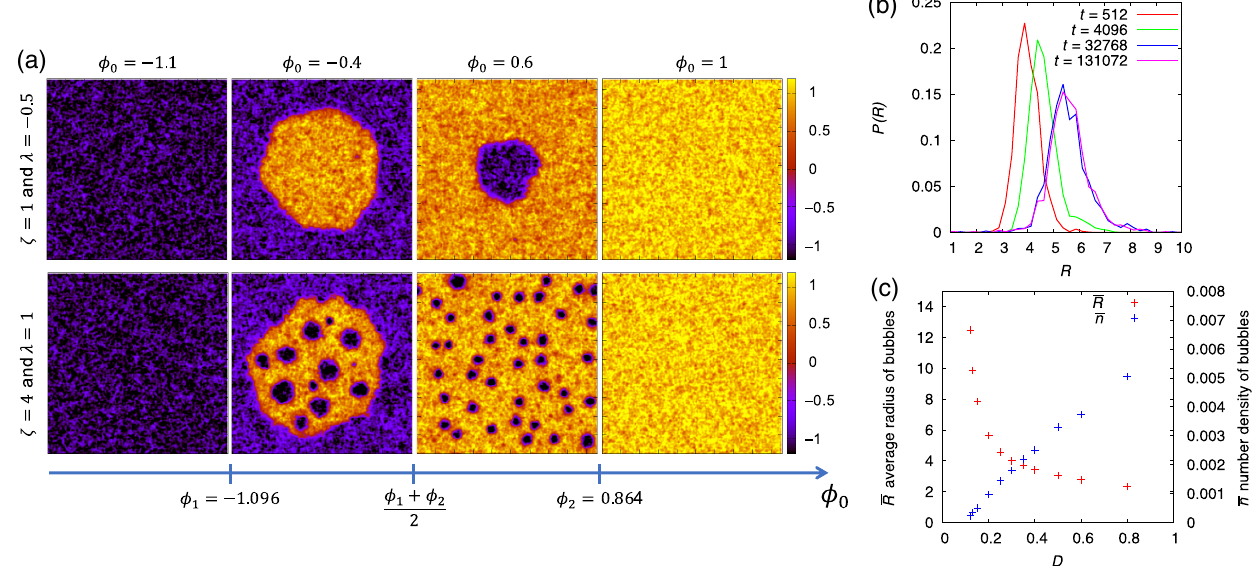
R d r ϕ for two different sets of activity parameters: FIG. 5. (a) Steady-state phase diagram as a function of global density ϕ 0 ¼ ð 1 =V Þ ζ ¼ 1 , λ ¼ − 0 . 5 corresponding to region A in Fig. 4(a), and ζ ¼ 4 , λ ¼ 1 corresponding to region C. In region A, the steady-state phase diagram resembles equilibrium Model B with full phase separation into dense (yellow) and dilute (blue) phases. In region C, besides the low- and high-density uniform phases, we observe either bubbly phase separation or a homogeneous bubble phase. Since AMB+ is symmetric under ð ϕ ; λ ; ζ Þ → − ð ϕ ; λ ; ζ Þ , the phase diagram in region B is obtained by exchanging dense and dilute regions. (b) Probability distribution of bubble radius for parameters ζ ¼ 4 , λ ¼ 1 as a function of time, starting from an initial uniform ¯ R density ϕ ð r ; t ¼ 0 Þ ¼ ϕ 0 ¼ 0 . 6 . The system reaches a steady state at t ≃ 32 000 . (c) Average radius of bubbles and number density of bubbles ¯ n in the homogeneous bubble phase as a function of D . Parameters are ζ ¼ 4 , λ ¼ 1 , and ϕ 0 ¼ 0 . 6